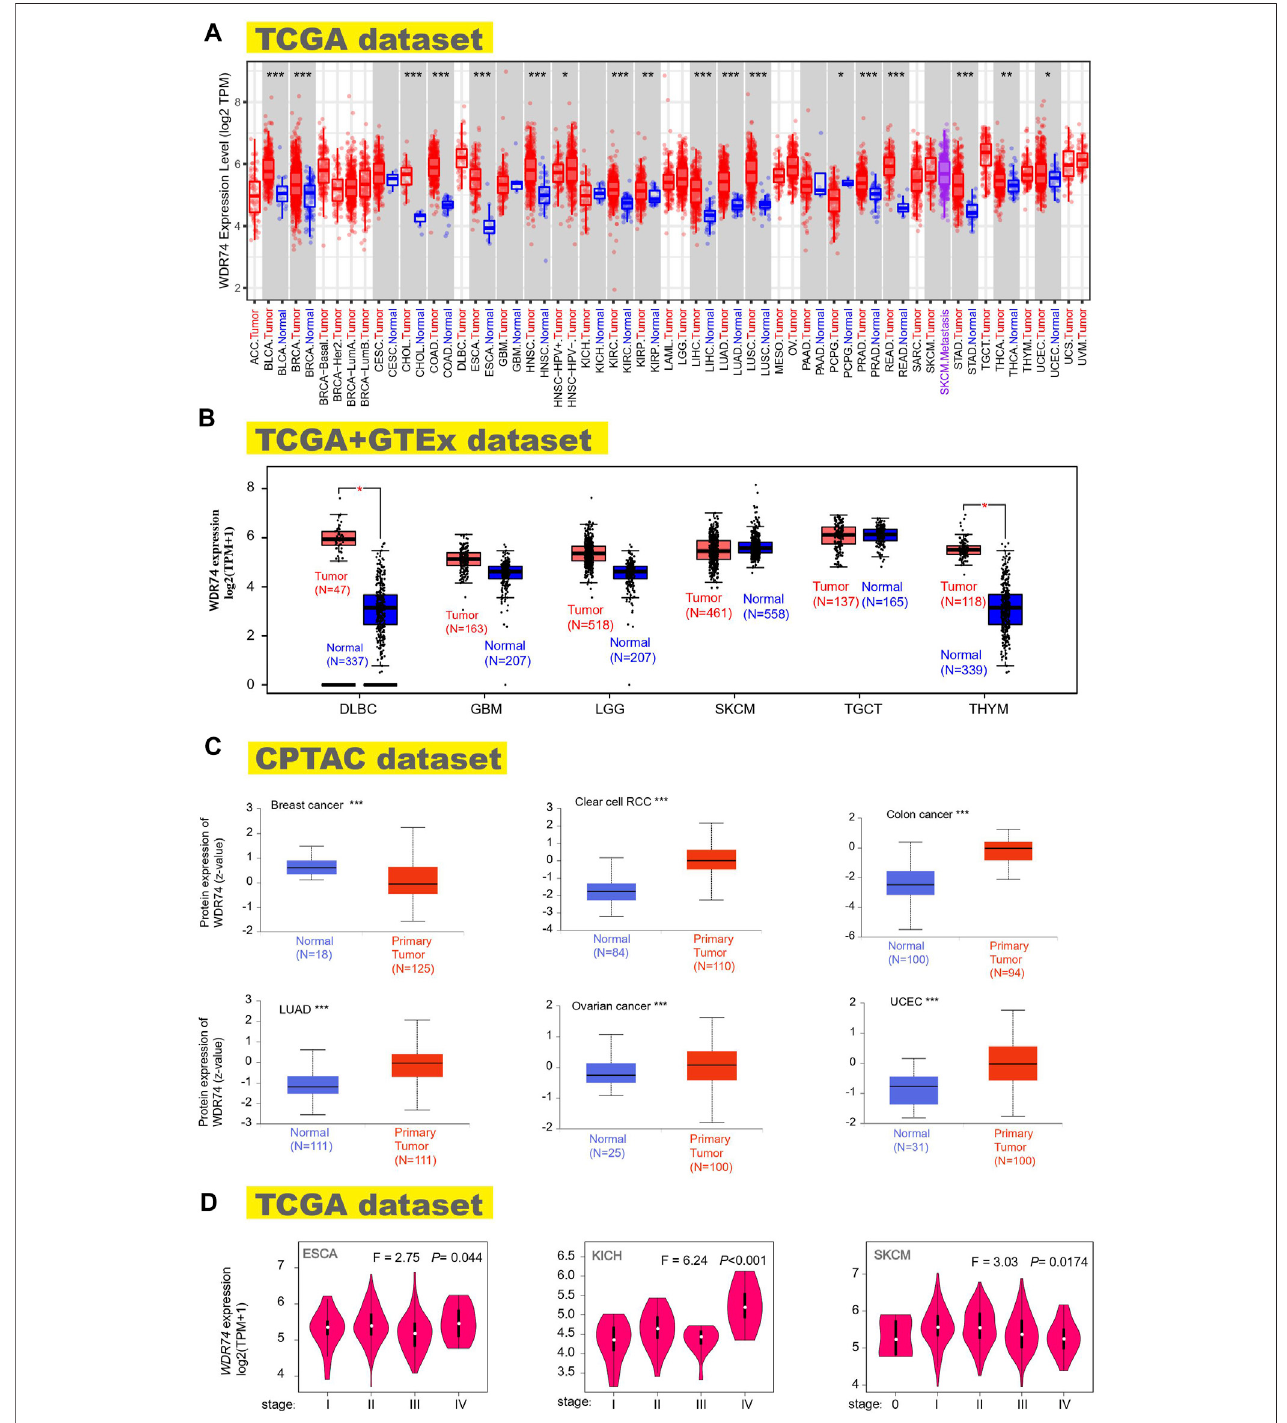
FIGURE 1 | Expression status of the WDR74 gene in multiple tumors and different pathological stages. We explored the WDR74 expression difference between tumorsamplesandpairednormaltissuesindifferentcancersorspeci fi ccancersutilizingTIMER2.* p < 0.05;** p < 0.01;*** p < 0.001 (A) .Combinedwithnormaltissuesin the GTEx database, WDR74 expression levels were analyzed for several tumors (DLBC, GBM, LGG, SKCM, TGCT, and THYM) in the TCGA project. * p < 0.05 (B) . WDR74 total protein expressions of normal tissues and primary tissues were obtained from the CPTAC dataset in breast cancer, clear cell RCC, colon cancer, LUAD, ovarian cancer, and UCEC. *** p < 0.001 (C) . WDR74 expression levels of different pathological stages were fi gured out in ESCA, KICH, and SKCM based on TCGA data (D) .